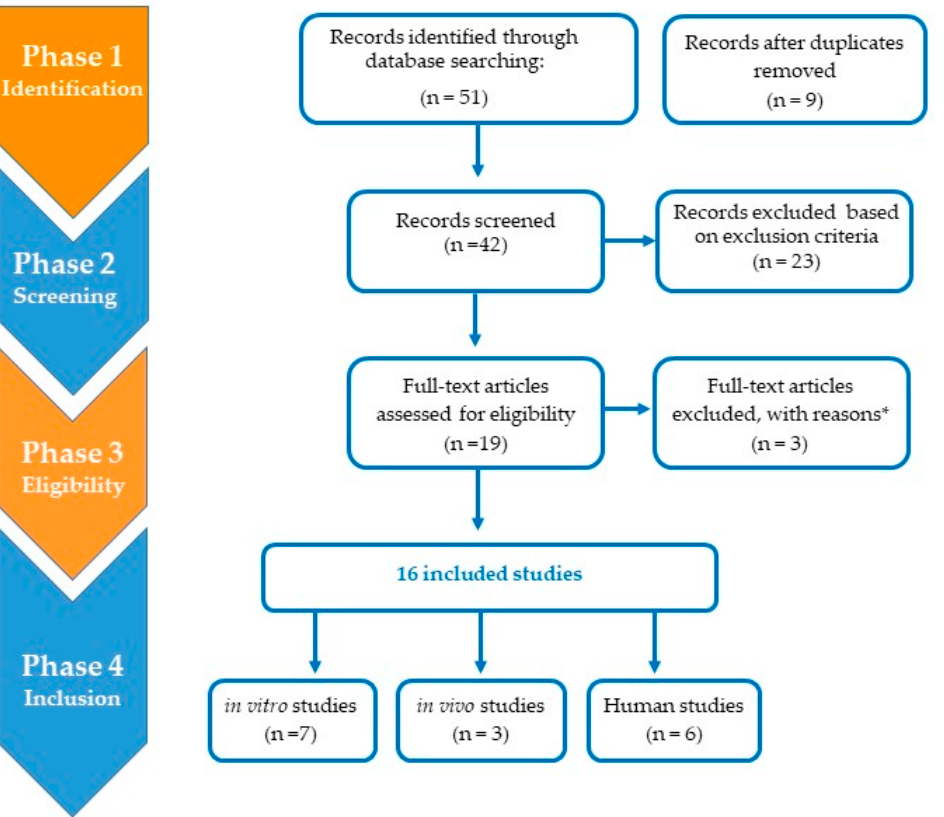
Figure 2. Flowchart of the selection process for articles. * When characterization of benzene exposure is not fully described.